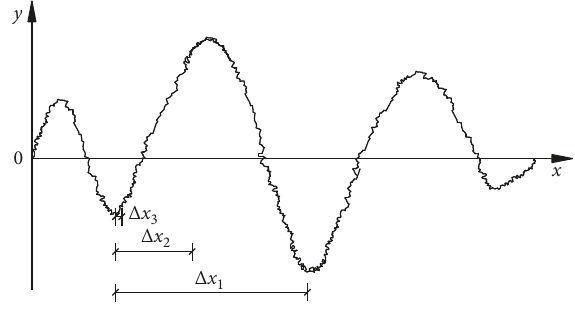
Figure 9: Sketch map of the Δ x